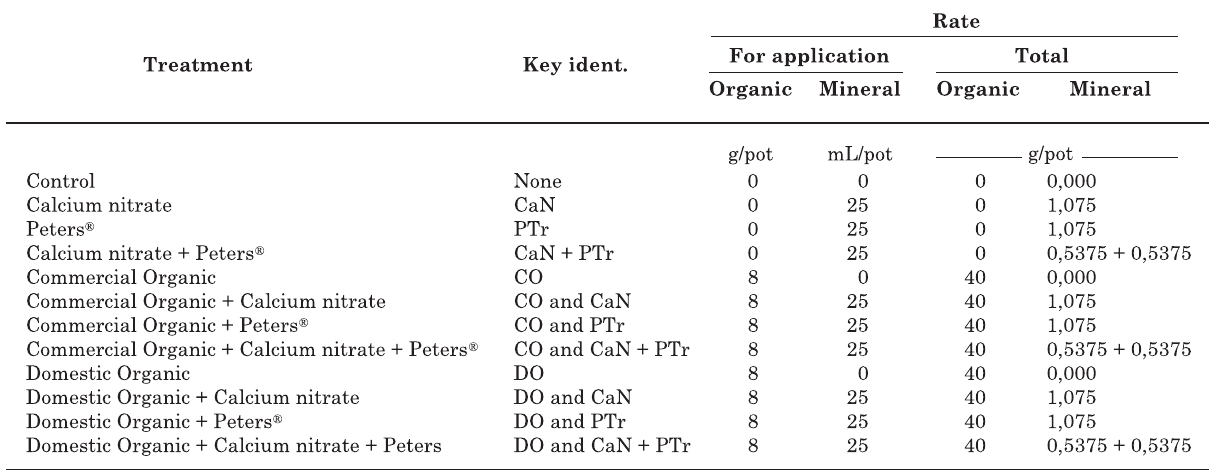
Table 1. Organic and mineral fertilizers in the tested combinations and